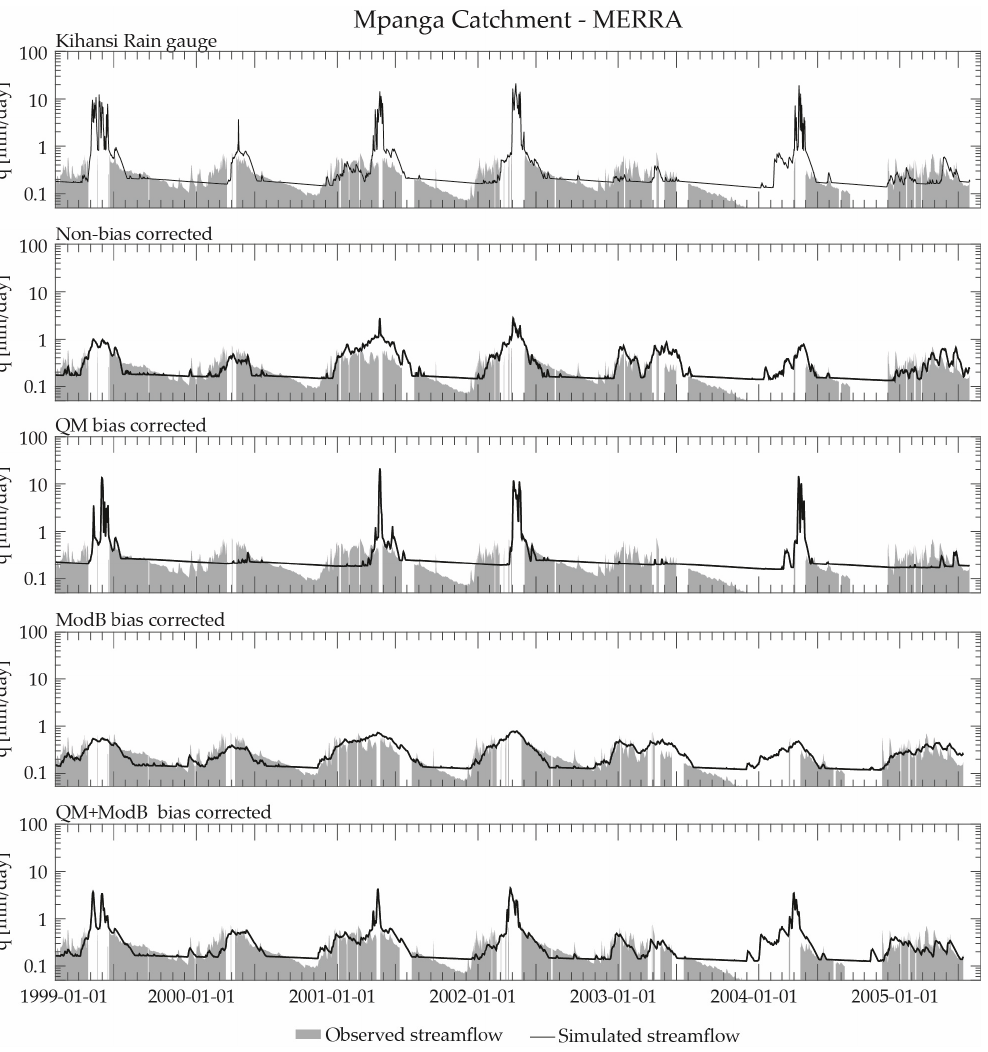
Figure 3. Semilog plots showing MC hydrographs of simulated (black line) and observed (grey filled area) specific discharge. Panels show observed and simulated discharge from calibrations using rain gauge data ( top ); the non-bias corrected data ( second ); quantile mapped (QM) bias corrected data ( third ); model based bias correction (ModB) bias corrected data ( fourth ) and combined QM + ModB bias corrected data ( bottom ).